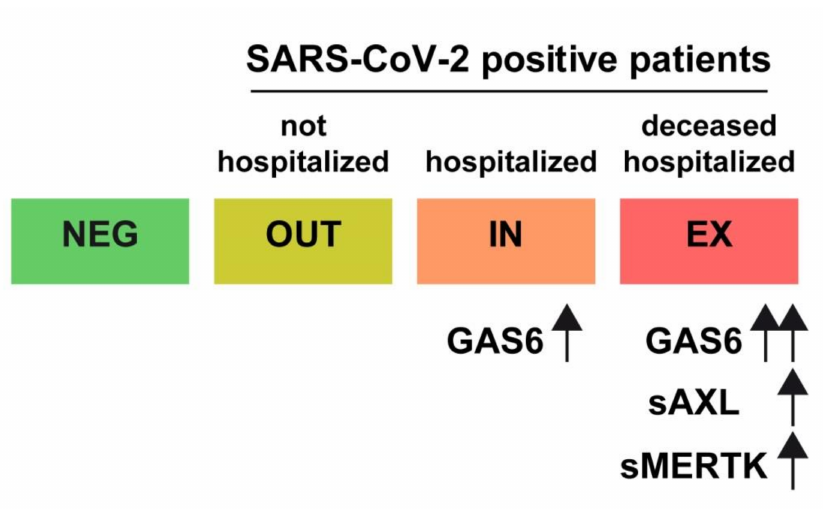
Figure 7. Schematic representation of early GAS6/AXL/MERTK changes in COVID-19 patients. Negative SARS-COV-2 patients and positive that did not require hospitalization exhibited no signifi- cant changes in GAS6-related proteins. Significant increase in GAS6 was observed in hospitalized patients, which were greater in deceased. Hospitalized patients that finally died also exhibited higher plasma concentration of sAXL and